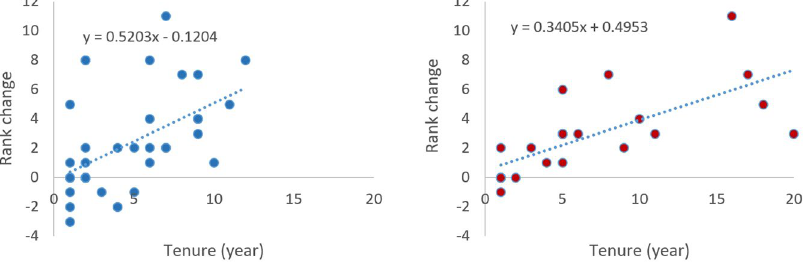
Figure 2. Relationship between tenure in the group and rank change (left: males; right: females). Tenure refers to the entire duration (number of years) an individual stays in the group. The regression equation for the dotted line in each panel shows the relationship in rank between tenure and rank change.